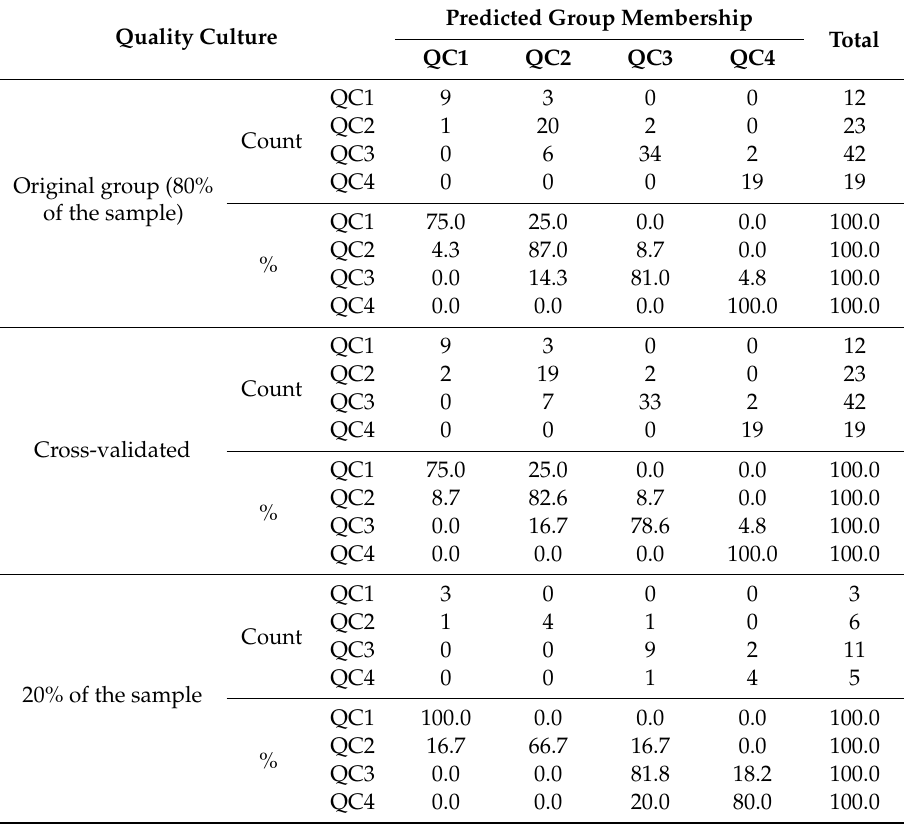
Table 18. Classification